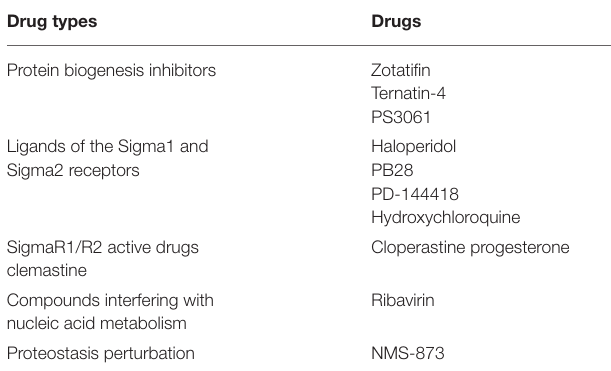
TABLE 2 | Representative ongoing clinical trials of antiviral therapy for COVID-19. TABLE 3 | List of different predicted possible